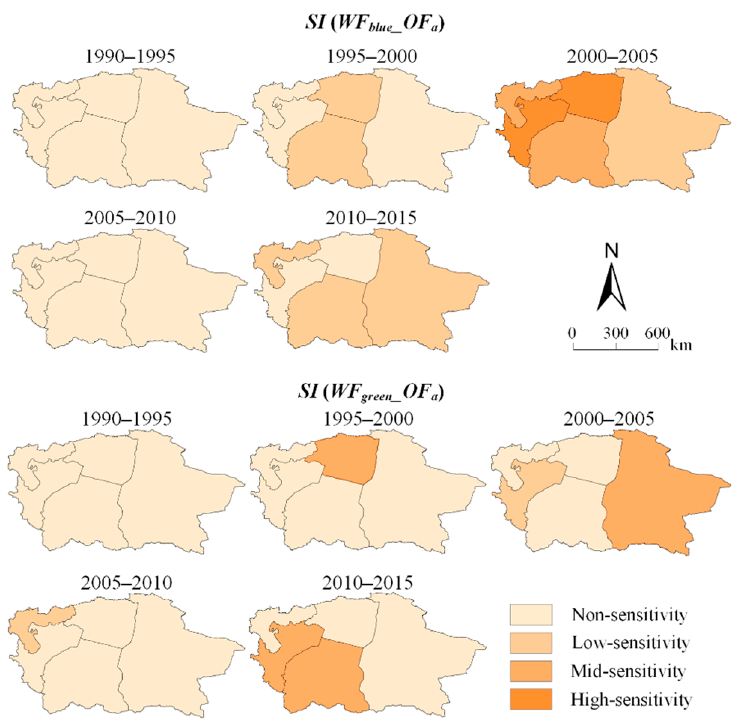
Figure 6. The spatial-temporal pattern of sensitivity from 1990 to 2015 .